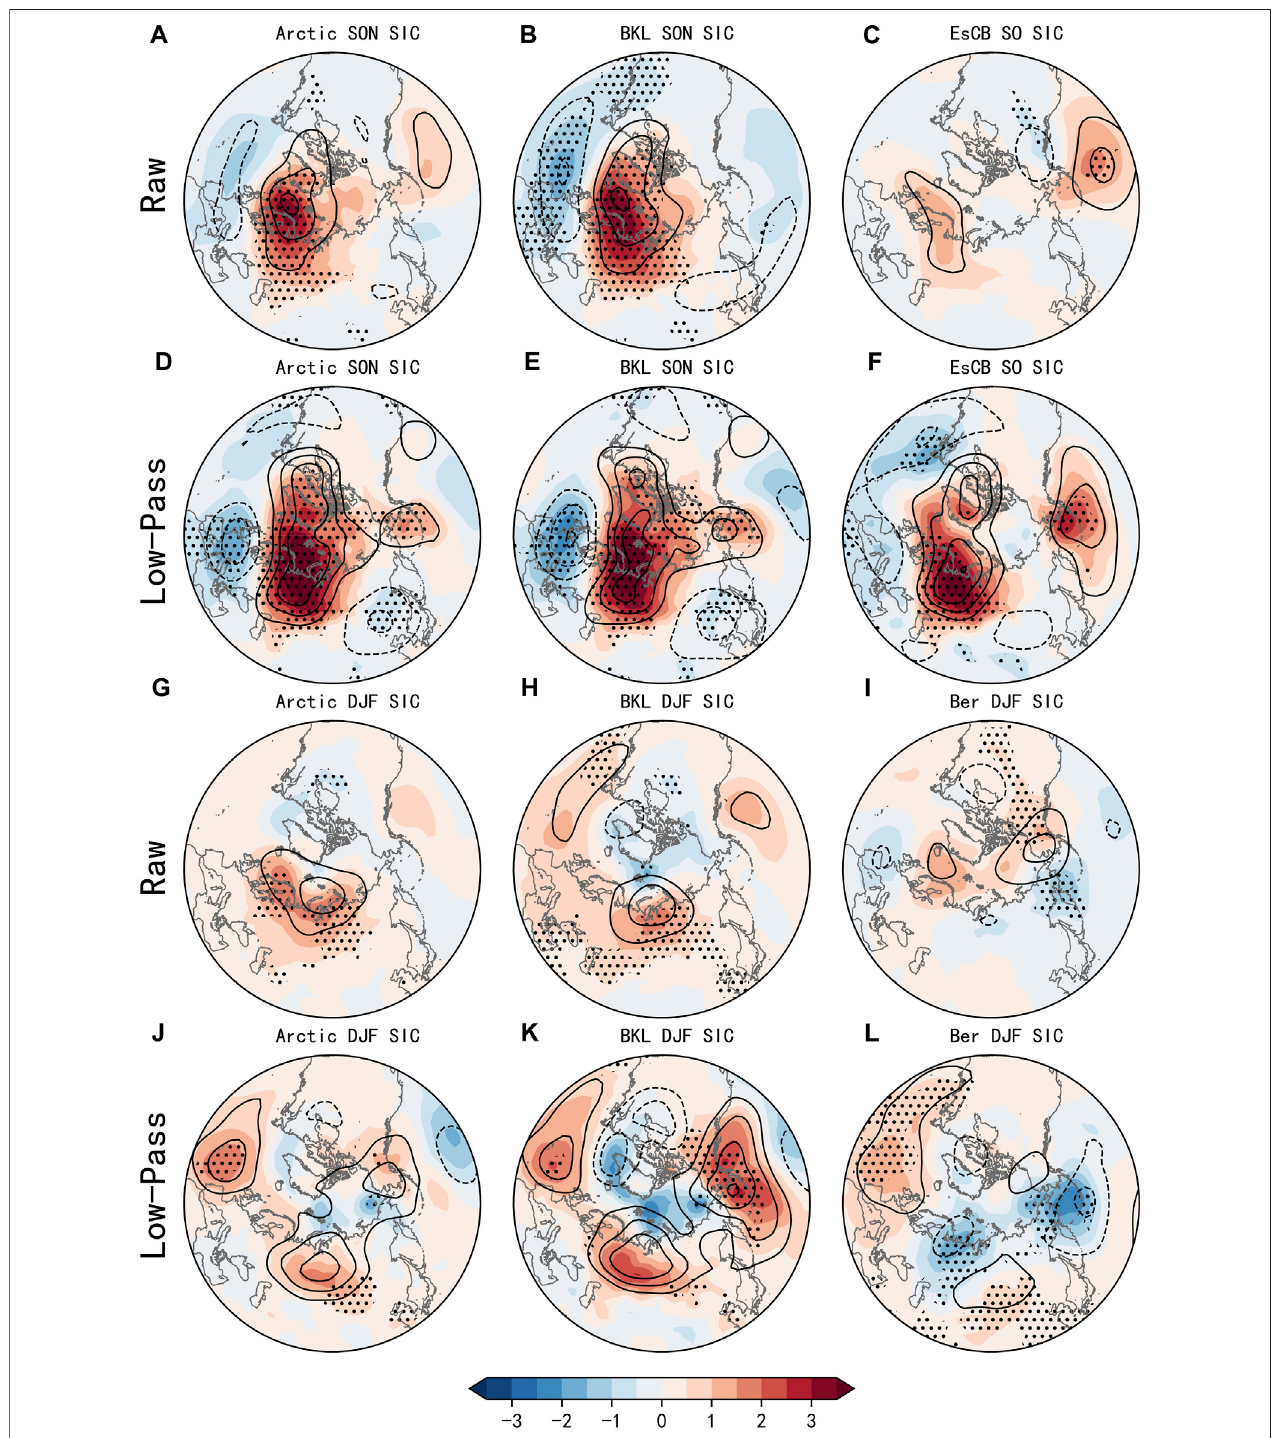
FIGURE 4 | As in Figure 3 but for SLP (shading; unit: hPa) and 500-hPa geopotential height fi elds (contours; interval: 10 m).